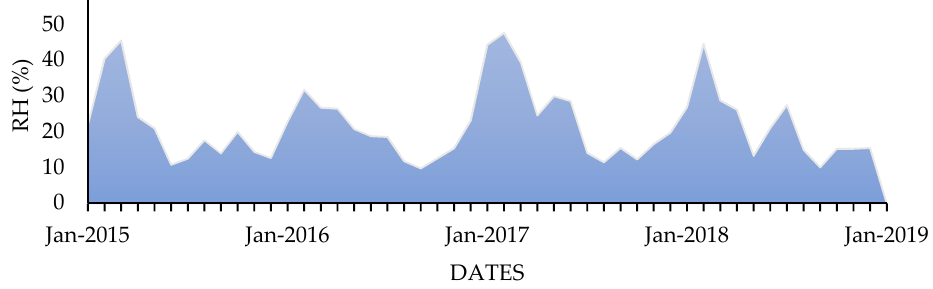
Figure 6. Relative humidity (RH) registered by Socaire station over four years.